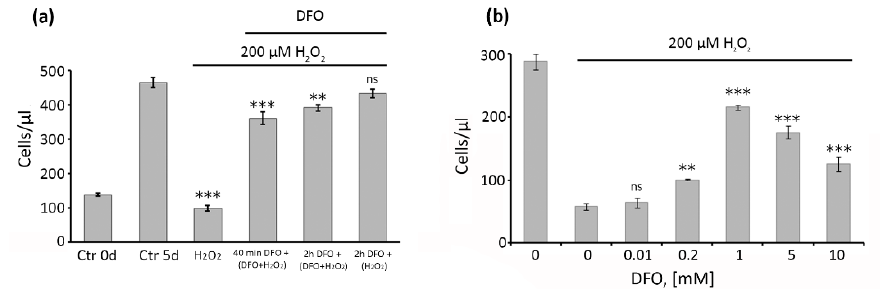
Figure 1. Pretreatment of hMESCs by DFO at concentration 1 mM for 2 h is optimal for protection of cells from oxidative stress-induced growth arrest. ( a ) Here we varied the time DFO pretreatment (40 and 120 min) and the mode (presence or absence of co-treatment with DFO and H 2 O 2 ) of DFO exposure; DFO was used at a concentration of 1 mM; after oxidative stress cells were washed from the drugs and cultivated in the fresh growth medium for additional five days; FACS analysis was performed five days after stress has been completed; cells number were determined as the number of PI-negative (live) cells; ( b ) dose-dependent effect of DFO against H 2 O 2 -induced growth inhibition in hMESCs. Cells were pretreated with the indicated concentrations of DFO for 2 h, then washed from DFO and subjected to oxidative stress with 200 μM of H 2 O 2 for 1 h; FACS was performed five days after the oxidative stress. Data are shown as Mean ± SD, n = 3; *** p ˂ 0.005, ** p < 0.01. Schemes follow the same formatting.